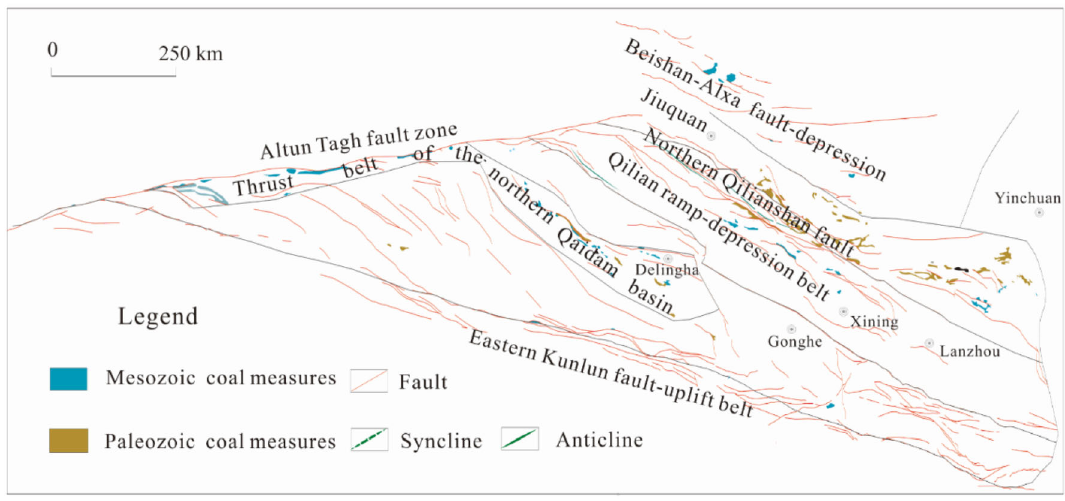
Fig. 14 Diagram of the structural outline in the Qilianshan–Kunlun Mountains coal occurrence structural subarea